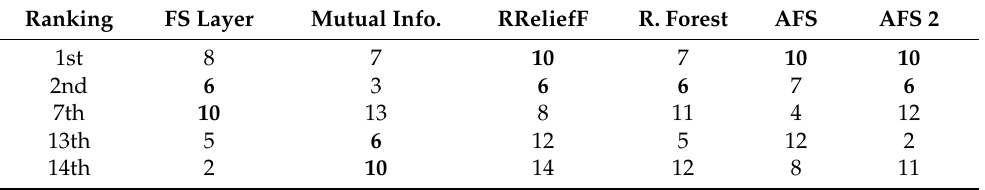
Table 11. Features ranked 1st, 2nd, 7th, 13th and 14th in the ranking, for the six compared techniques. Ranking FS Layer Mutual Info.